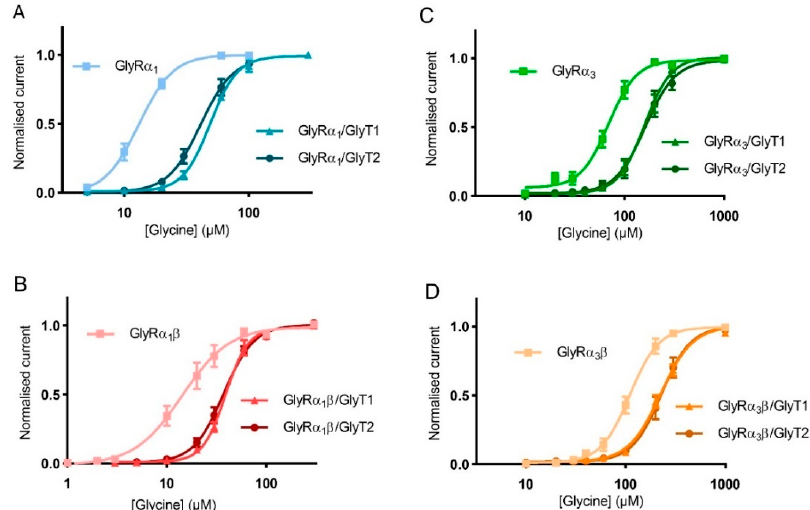
Figure 6. GlyTs also modulate the activity of GlyR α 3 and GlyR α 3 β . Glycine dose responses are shifted to the right and EC 50 values for ( A ) GlyR α 1 , ( B ) GlyR α 1 β , ( C ) GlyR α 3 and ( D ) GlyR α 3 β are increased when co-expressed with GlyT1 or GlyT2. Currents were normalised to I max and fit to the Hill equation. Symbols represent mean ± SEM, n =